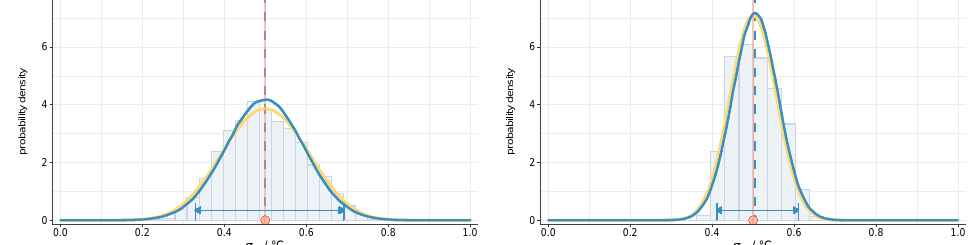
Figure 9. Posterior distribution of σ ε for a single dataset of E2 (Issue 2) with 95%-HPD regions, true value (red circle) and prior distribution p ( σ ε ) ∼ B ( a 0 , b 0 ) (yellow line). ( Left ) n 2 = 100 and a 0 = b 0 = 12; ( right ) n 3 = 500 and a 0 = b 0 = 40.